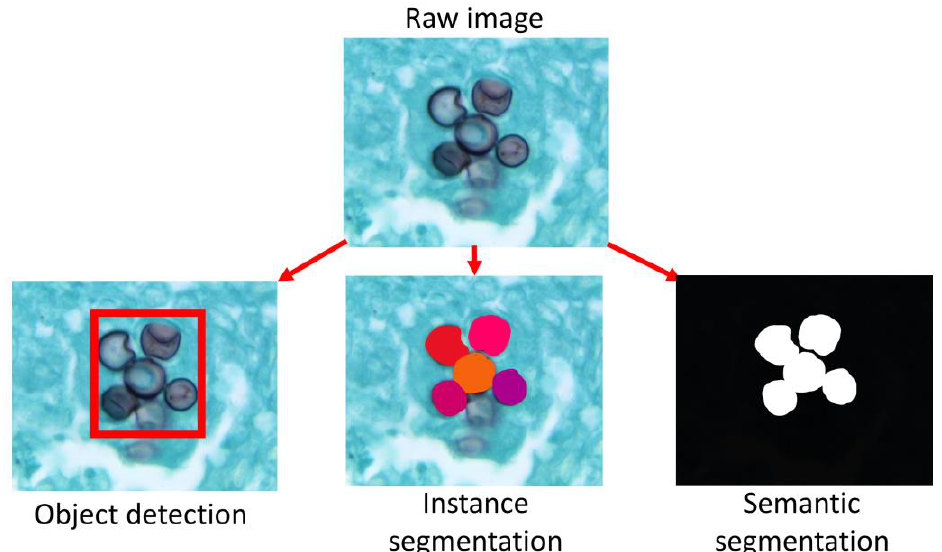
Figure 2. Here a cluster of Paracoccidioides brasiliensis cells are annotated in a photomicrograph (source: CDC Public Health Image Library) by three different methods: object detection, instance segmentation and semantic segmentation. Object detection results in a region of interest (red border, right panel) while instance segmentation produces a mask of the area of each cell (colored regions, center panel) and semantic segmentation produces a binary image with each pixel labelled as ‘background’ (black) or ‘cell’ (white) (left panel).